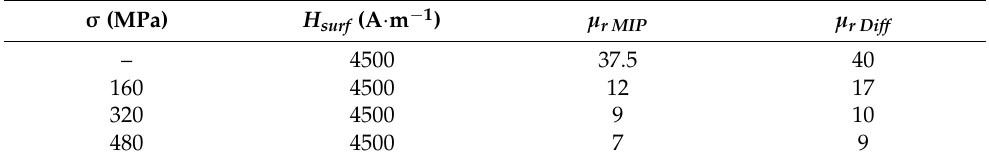
Table 2 comparisons confirm our expectations and the relatively similar permeabilities in the saturated range. Table 2. Comparisons between µ r MIP and µ r Diff in the high H surf amplitude range (saturated zone).